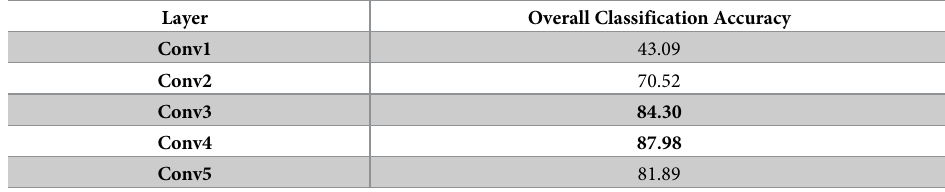
Table 1. Classification accuracies for various layers in our CNN.